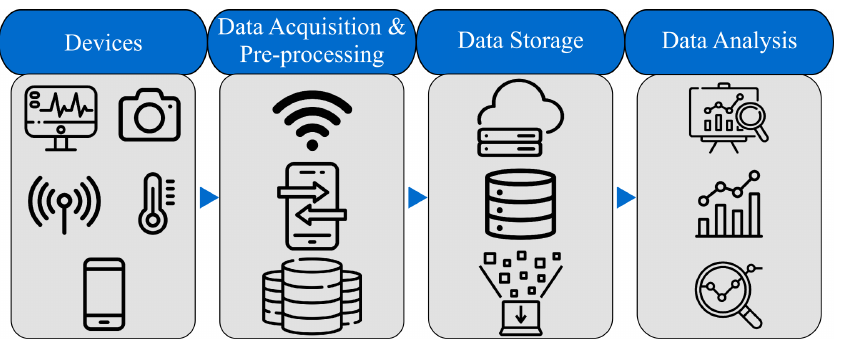
Figure 5. Stages of IoT in Healthcare